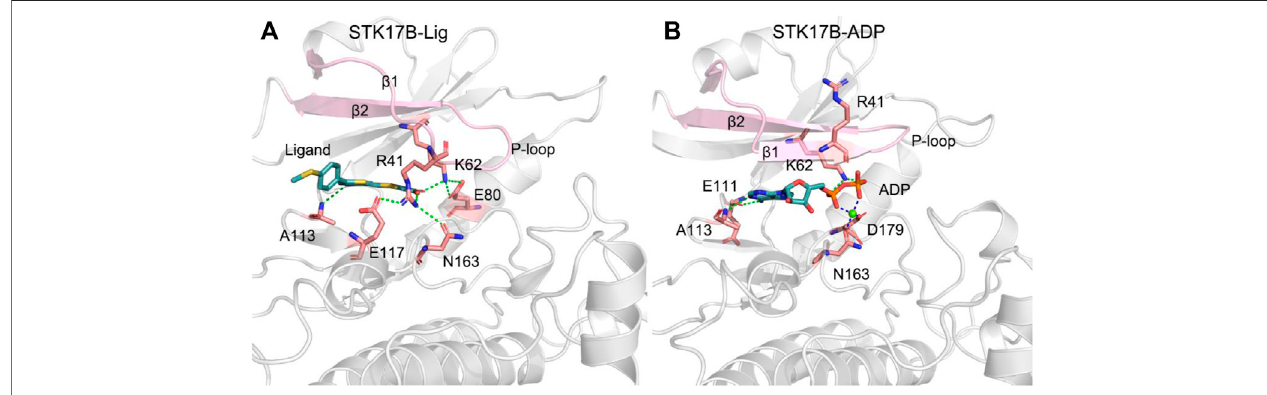
FIGURE 8 | The most representative structural complexes of ligand-bound (A) and ADP-bound (B) STK17B. The β 1 and β 2 and the P-loop are colored by pink. Hydrogen bonds or salt bridges are shown by green dotted lines. Coordinated bonds are shown by blue dotted